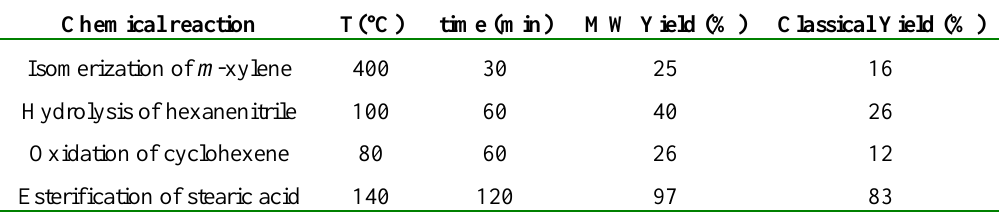
Table 1. Heterogeneous reactions under microwave and classical heating. Chemical